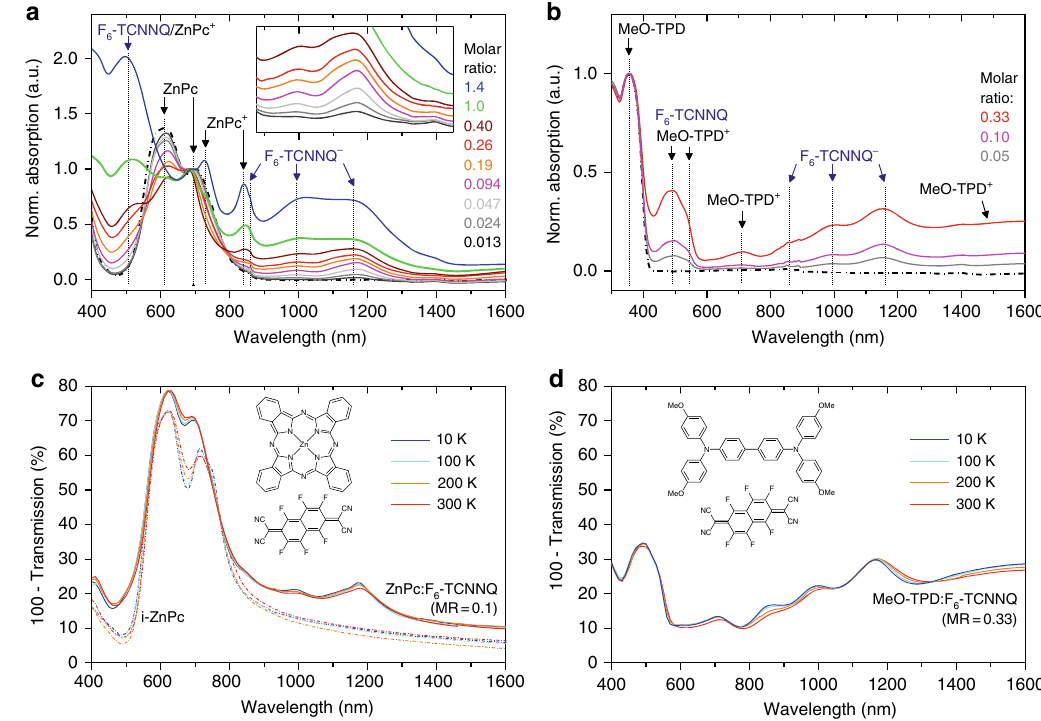
Fig. 2 Absorption spectroscopy on p-doped fi lms. Normalized absorption spectra of a ZnPc:F 6 -TCNNQ and b MeO-TPD:F 6 -TCNNQ thin fi lms of varying doping ratio measured at RT, evidencing integer-charge transfer (ICT) each. c , d Respective transmission spectra of representative doped fi lms under temperature variation ( T = 10 … 300 K). Spectra of undoped ZnPc and MeO-TPD fi lms are given as dash-dotted lines. Energy values are as follows: IE = 5.0 eV, IE = 5.1 eV, and EA = 5.2 eV 15 , the corresponding molecular structures are given in panel c and UPS (ZnPc) UPS (MeO-TPD) DFT (F 6 -TCNNQ) + → + − → − – 41 (sub-gap) transitions, i.e., D D * and A A * excitations 39 . This fi ngerprint is distinct from possibly formed supramolecular + δ − δ A complexes with fractional charge transfer (CT), δ < 1, D